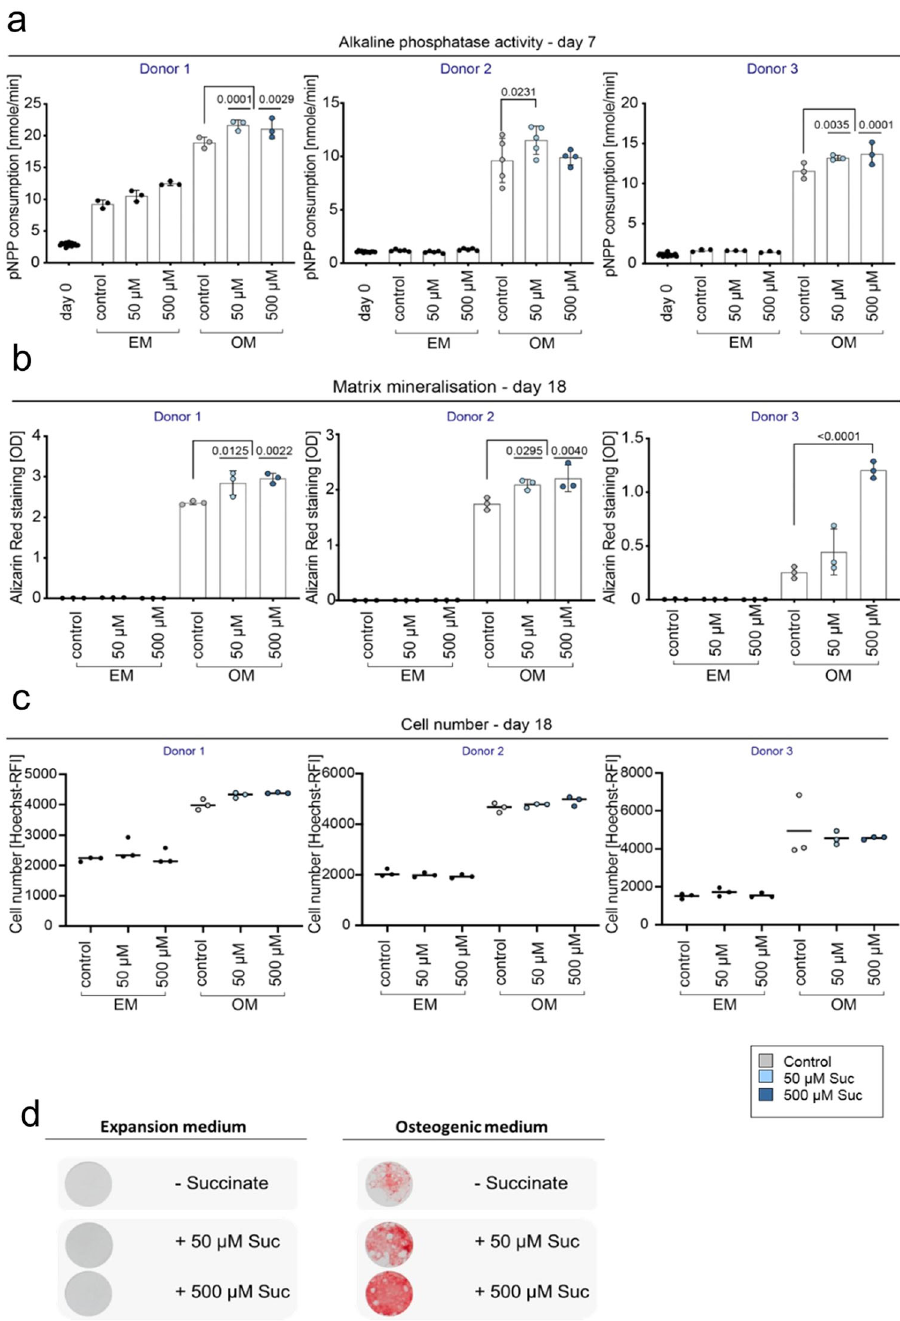
Fig. 8 In vitro osteogenic differentiation of human MSCs is enhanced upon extracellular stimulation with succinate. a Enzymatic activity of alkaline phosphatase, early phase marker of osteogenic differentiation, is signi fi cantly increased at day 7 in conditions with succinate treatment (50 µ M, 500 µ M), n = 3-5 individual experimental replicates per donor, One-way ANOVA, mean ± standard deviation. b Alizarin red staining used to identify mineralized matrix formation and osteogenic differentiation shows higher values in succinate treated conditions, compared to control osteogenic differentiation at day 18. n = 3 individual experimental replicates per donor, One-way ANOVA, mean ± standard deviation c Cell number determined by Hoechst staining is not altered between the treatments (control versus succinate) at day 18 of the differentiation. n = 3 experimental replicates per donor, dot plot shows the mean, One-way ANOVA. d Exemplary light microscopic picture of alizarin red staining at day 18 shown for osteogenic versus control (expansion medium) conditions and succinate treated wells. EM expansion medium, OM osteogenic medium, Suc succinate, pNPP 4-nitrophenylphosphate, OD optical density, RFI relative fl uorescence